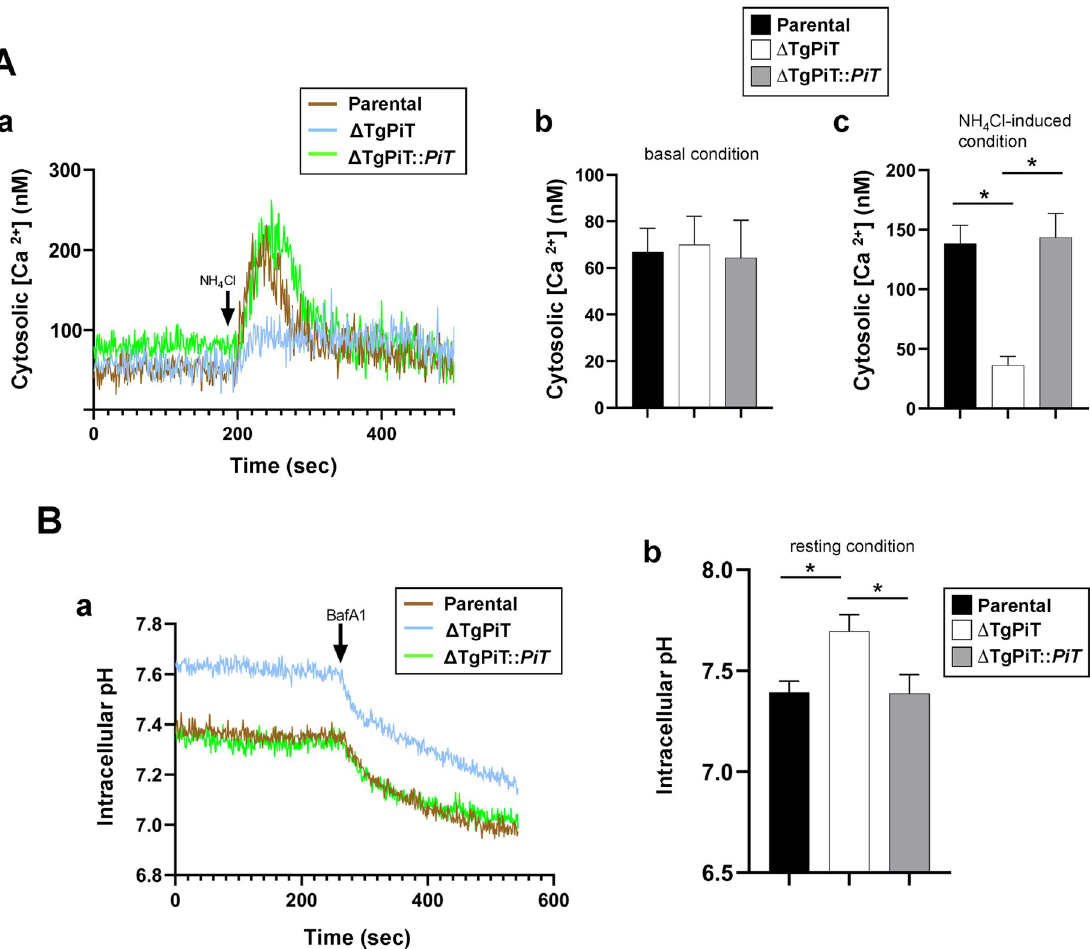
Fig 12. Ion homeostasis in Δ TgPiT parasites. A. Calcium regulation in Δ TgPiT parasites and the effect of NH 4 Cl-induced calcium release from acidic compartments. Panel a: Representative tracings of cytosolic Ca 2+ measurements on extracellular parental, Δ TgPiT and Δ TgPiT:: PiT parasites loaded with the ratiometric fluorescent indicator Fura-4F-AM. Each tracing is representative of 3 independent experiments. NH 4 Cl at 10 mM was added at 200 sec to induce Ca ++ release from acidic stores. Panels b and c: Quantification of tracings from 3 independent experiments showing the ratiometric Fura-4F-AM fluorescence for the 3 parasite strains, before and after NH 4 Cl addition. Data are mean ± SEM. � , p = 0.0078 (KO vs. parental) and p = 0.0061 (KO vs. complemented) (Tukey’s multiple comparisons test). B. pH regulation in Δ TgPiT parasites and the effect of bafilomycin A1 (BafA1). Representative tracings showing the intracellular pH of parental, Δ TgPiT and Δ TgPiT:: PiT parasites measured via BCECF-AM ratiometric fluorescence. Each tracing is representative of 3 independent experiments. The V-H+-ATPase inhibitor BafA1 at 10 nM was added at 250 sec to depolarize the plasma membrane. Panel b: Quantification of tracings from 3 independent experiments showing the average intracellular pH in the three parasite strains Data are mean ± SEM. � , p < 0.0001 (Tukey’s multiple comparisons test).